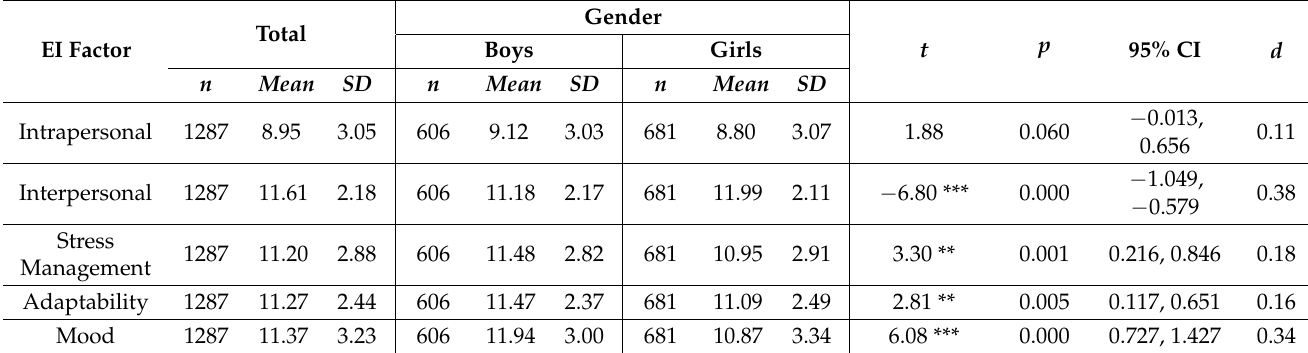
Table 1. Emotional intelligence by gender. Descriptive statistics and Student’s t